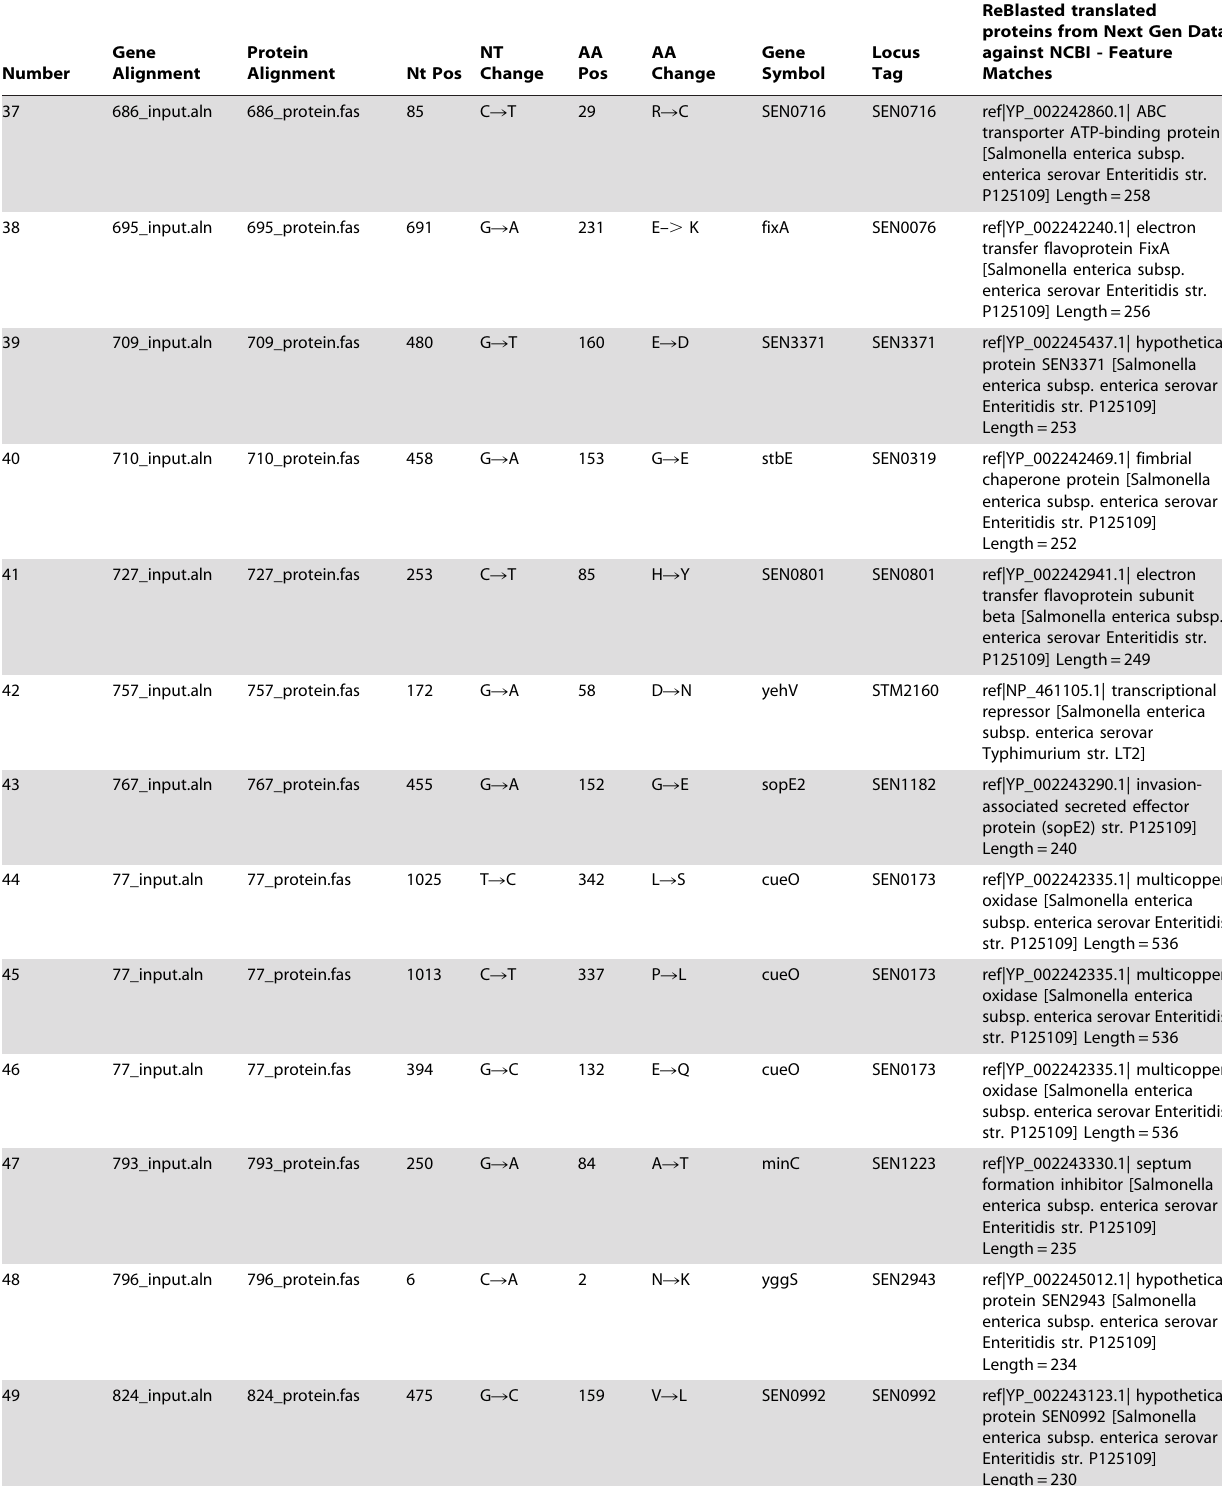
Variable genes observed that may define Salmonella